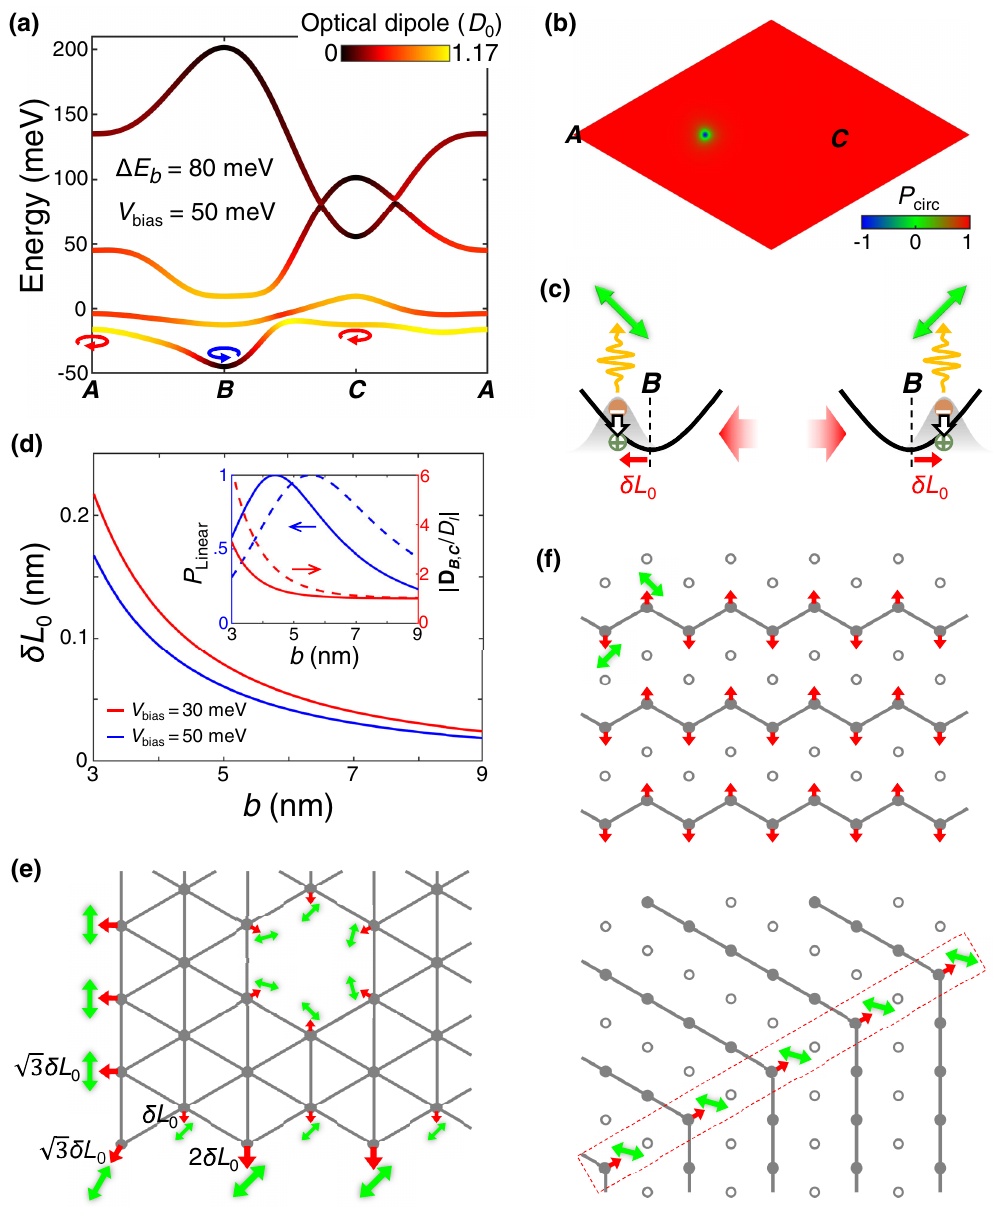
FIG. 4. Anomalous luminescence in a triangular lattice of repulsive interactions. (a) Moir´e superlattice potentials for the four ¼ 80 meV and an interlayer bias V ¼ 50 meV that lifts the decoupled exciton branches under a larger binding energy difference Δ E b bias degeneracy at B and C . (b) Emission polarizations in the lowest-energy branch, changing rapidly in the neighborhood of the trapping site B . (c) In this triangular lattice, the dipolar repulsion between nearest-neighbor B sites pushes the two trapped excitons away from each other by a tiny displacement, which results in orthogonal linear polarizations of their emissions. (d) The equilibrium δ L 0 in moir´e of various period b under two V values. The inset shows the degree of linear polarization and optical dipole strength for a site bias ¼ 50 meV. (e) The displacements (red arrows) and emission linear displacement of δ L 0 (solid line) and 2 δ L 0 (dashed line) under V bias polarizations (green double arrows) for the unbalanced sites at the edges and vacancies under full filling. The equilibrium displacement ffiffiffi p 3 δ L 2 δ L 1 = 2 , where radiative recombination occurs in the bulk can be δ L 0 , 0 , or 0 . (f) Two distinct stripe phases under the filling factor and at domain boundaries, respectively. Solid (empty) dots denote the occupied (unoccupied)